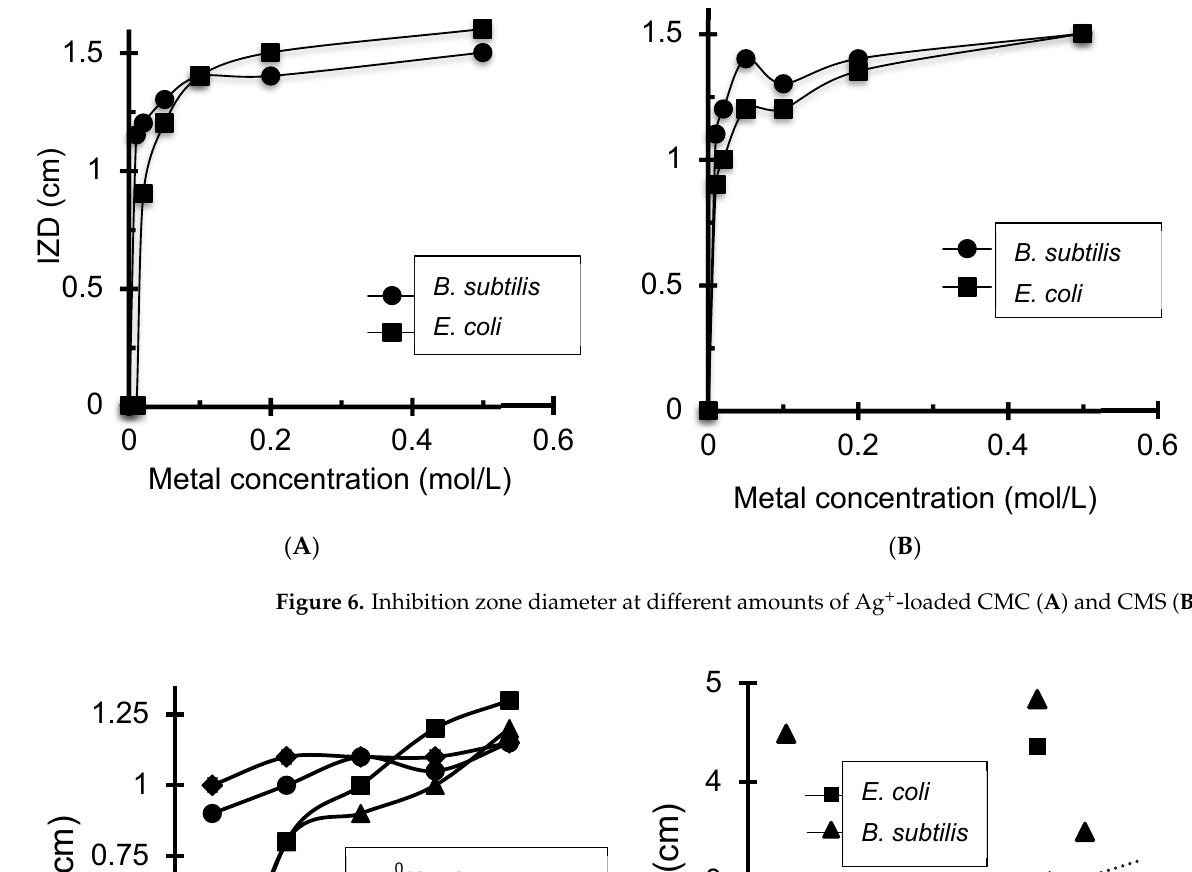
Figure 6. Inhibition zone diameter at different amounts of Ag + -loaded CMC ( A ) and CMS ( B ).